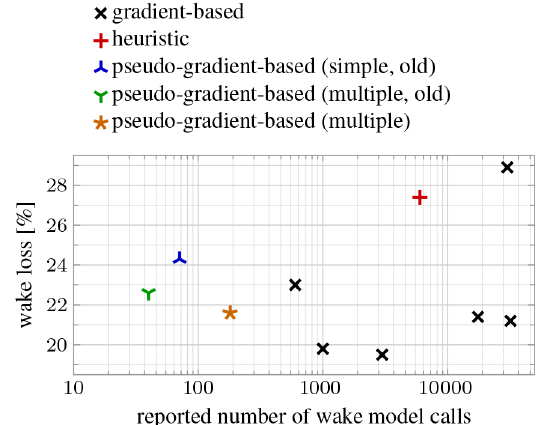
Figure 14. Scatter plot of IEA Wind Task 37 Case Study 1 64- turbine scenario wake loss percentage vs. reported number of wake model